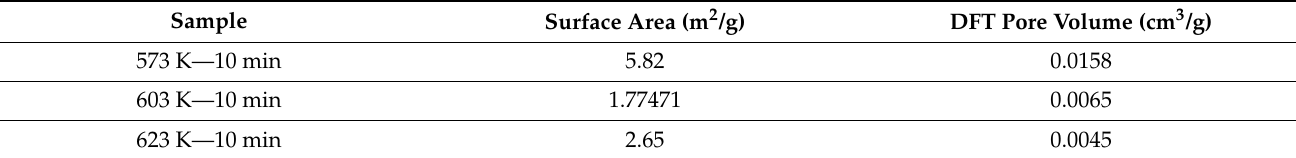
Table 3. Surface area and pore volume variation at different operating temperatures at 10 min residence time.